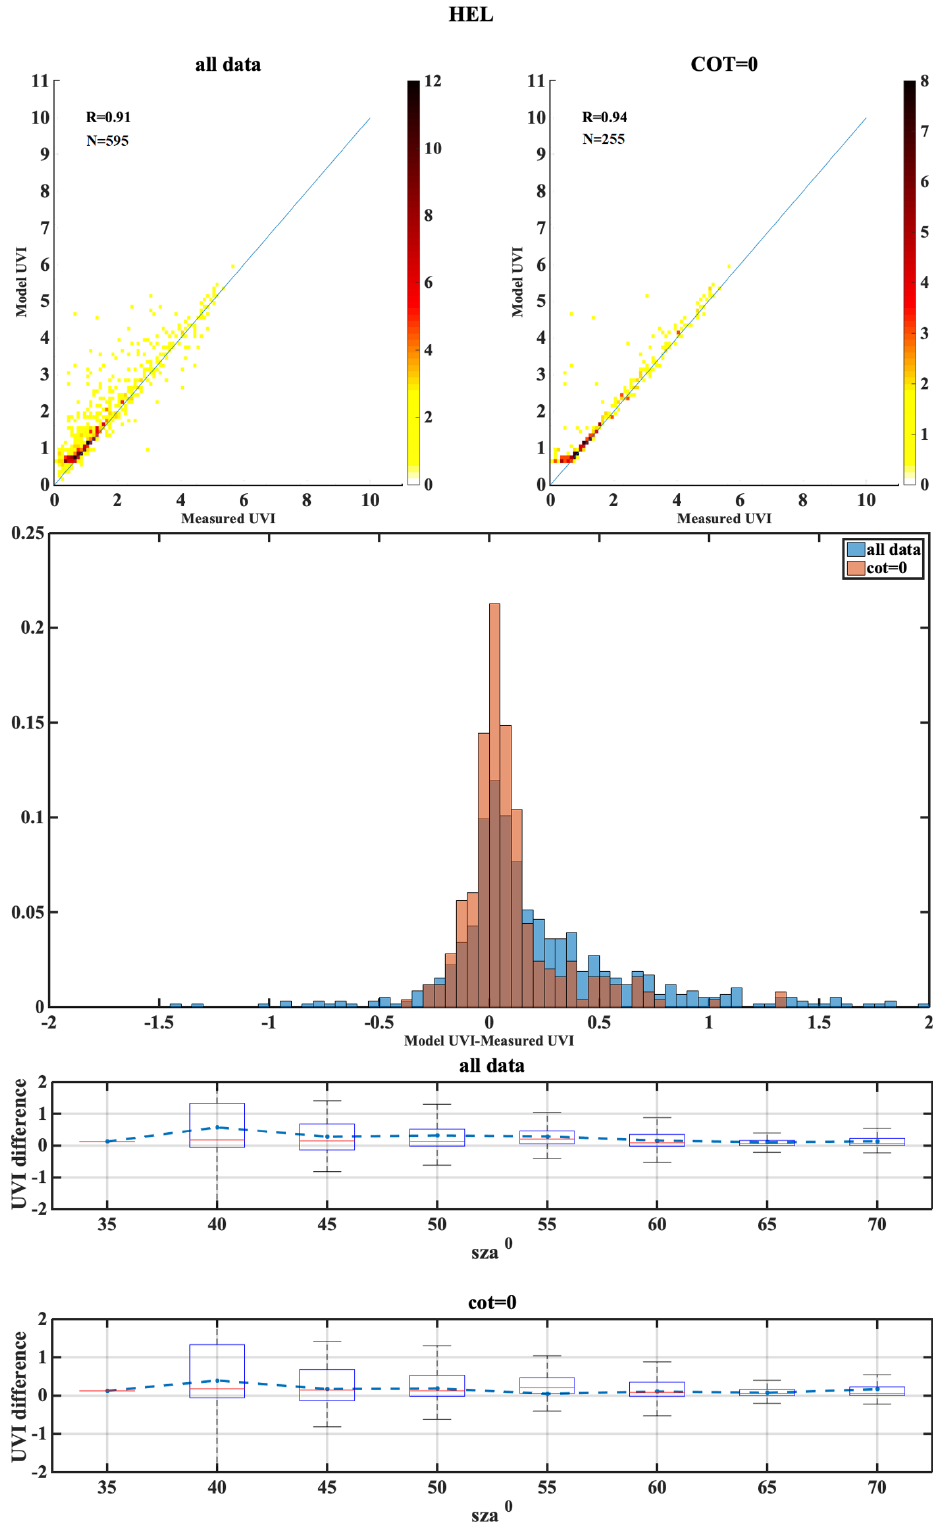
Figure A7. Same as above but for the HEL